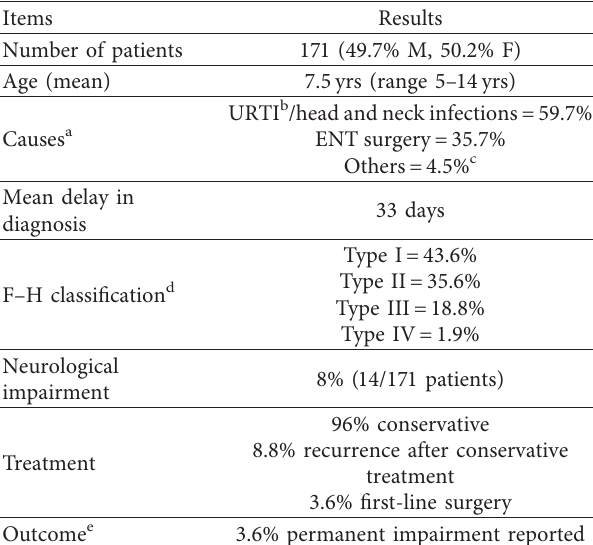
Figure 3: PRISMA flow diagram of papers selection [19]. Table 2: Synthesis of